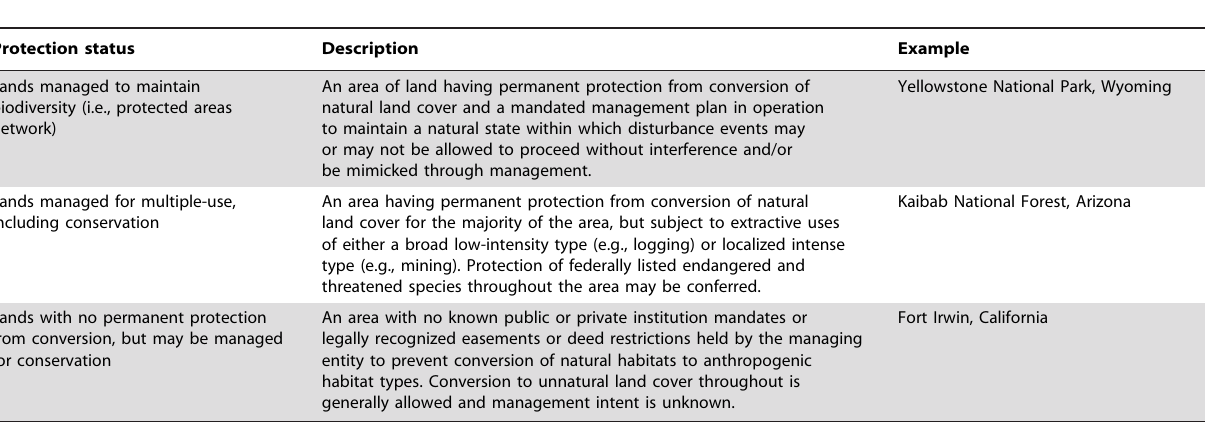
Table 1. Description of protection status categories in the Protected Areas Database for US